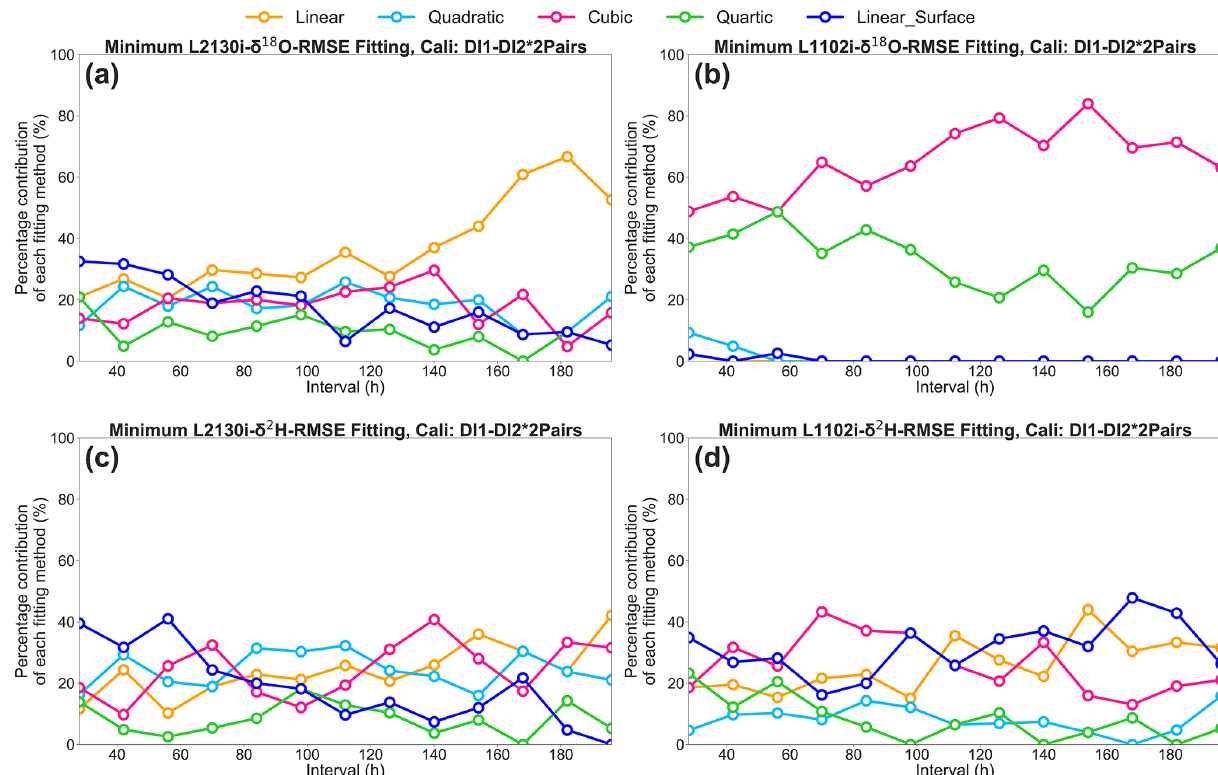
Figure 7. Percentage contribution of the respective five [H 2 O] dependence fittings (i.e. linear, quadratic, cubic, quartic, and linear surface fitting methods) to the total calibration pairs, which only obtained minimum RMSE values of δ 18 O and δ 2 H, at each interval for the DI1– 2*2Pairs calibration strategy. (a) L2130i’s and (b) L1102i’s results for δ 18 O RMSE. (c) L2130i’s and (d) L1102i’s results for δ 2 H